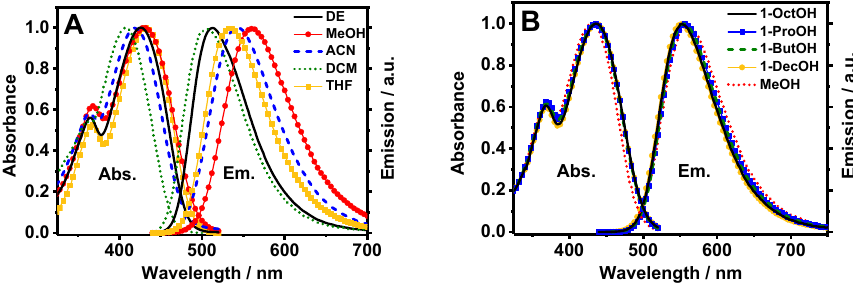
Figure 1. Normalized UV-visible absorption and fluorescence spectra of dimethyl 4-amino-8-cyanonaphthalene-2,6-dicarboxylate (Me 2 CANADC) linker in ( A ) dichloromethane (DCM) (green short dot), acetonitrile (ACN) (blue short dashes), diethyl ether (DE, black solid line), methanol (MeOH, red full circles), tetrahydrofuran (THF, orange full squares) and in ( B ) MeOH (red short dots), 1-propanol (1-ProOH, blue full squares), 1-butanol (1-ButOH, green short dashes), 1-octanol (1-OctOH, black solid line), and 1-decanol (1-DecOH, orange full circles). The excitation wavelength for the fluorescence spectra was 425 nm.